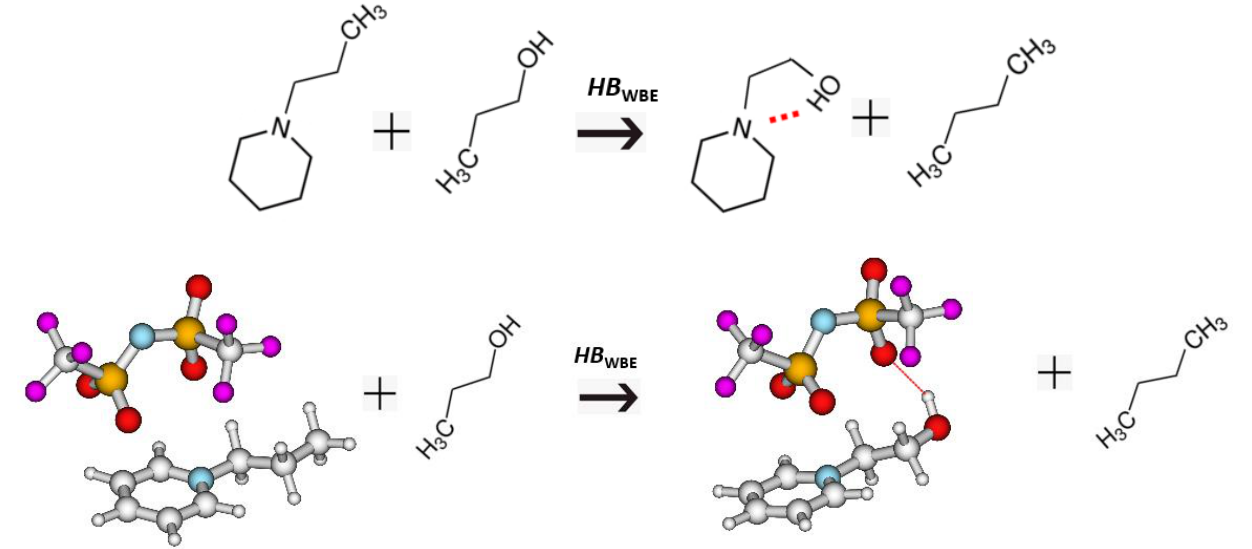
Figure 5. Well-balanced equations: the development of the “non-hydrogen-bonded” reference systems for calculating the intra-molecular hydrogen-bonding strength, HB WBE , in hydroxy-alkyl-piperidines and hydroxy-alkyl-pyridinium [NTf 2 ] ionic liquids.